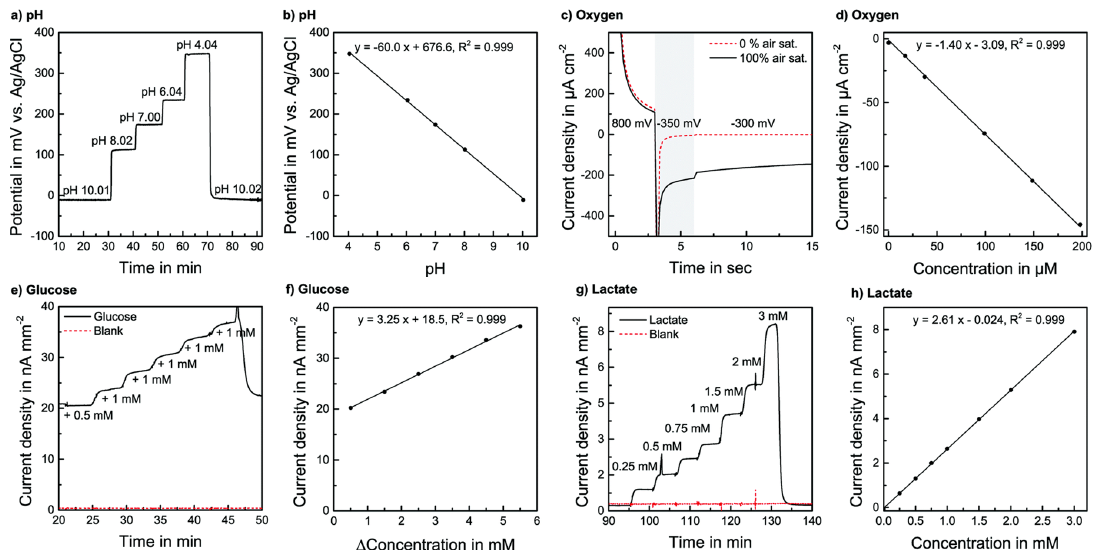
Figure 4. Sensor characterization in a cell culture medium at 37 °C at a flow rate of 2 μL·min −1 : ( a ) Transient pH measurement. ( b ) Calibration for pH. (c) Current response of a 3-step chronoamperometric dissolved oxygen measurement protocol, with and without oxygen. ( d ) Calibration for dissolved oxygen. ( e ) Transient glucose measurement for glucose and a blank electrode, by spiking a medium containing glucose. ( f ) Glucose calibration with the blank signal subtracted. ( g ) Transient lactate measurement for lactate, and blank electrode in medium without FBS. ( h ) Lactate calibration with the blank signal subtracted. Reproduced from [79], with permission from the Royal Society of Chemistry, 2014.